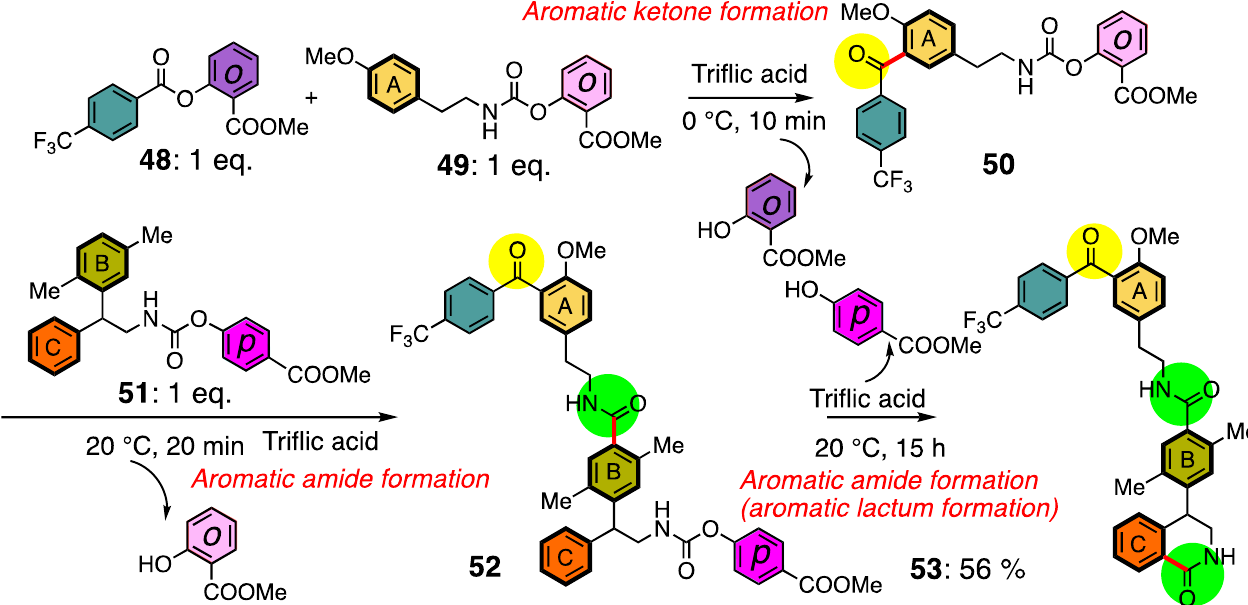
Scheme 13. Tandem reaction using sequentially generated electrophile species in a one-pot